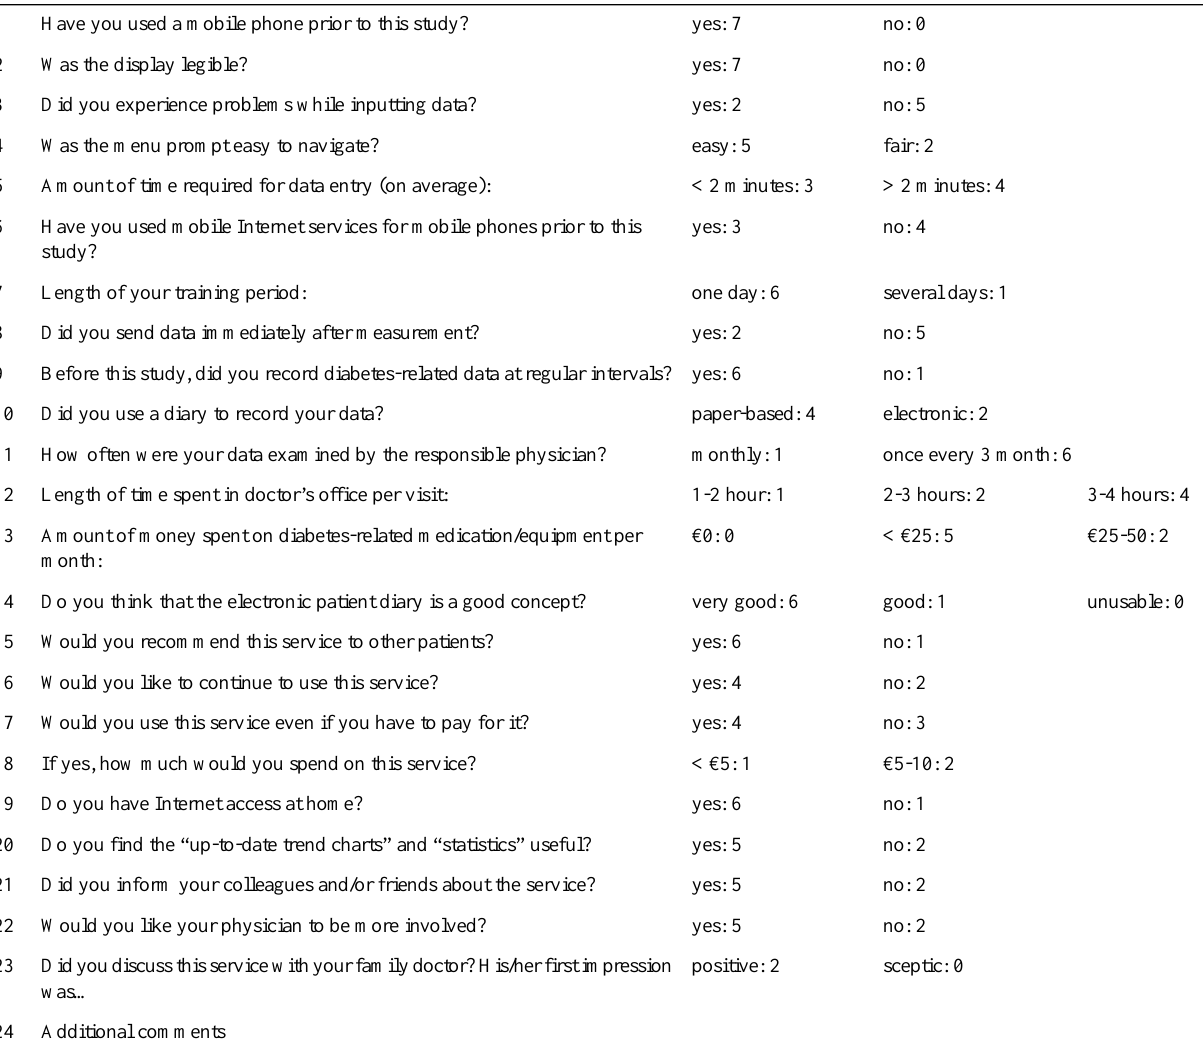
Table 2. Patient questionnaire (translated from German) on the diabetes management service (n =